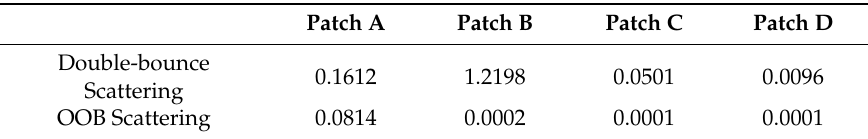
Table 3. Averaged magnitude of scattering power for GF3 data.